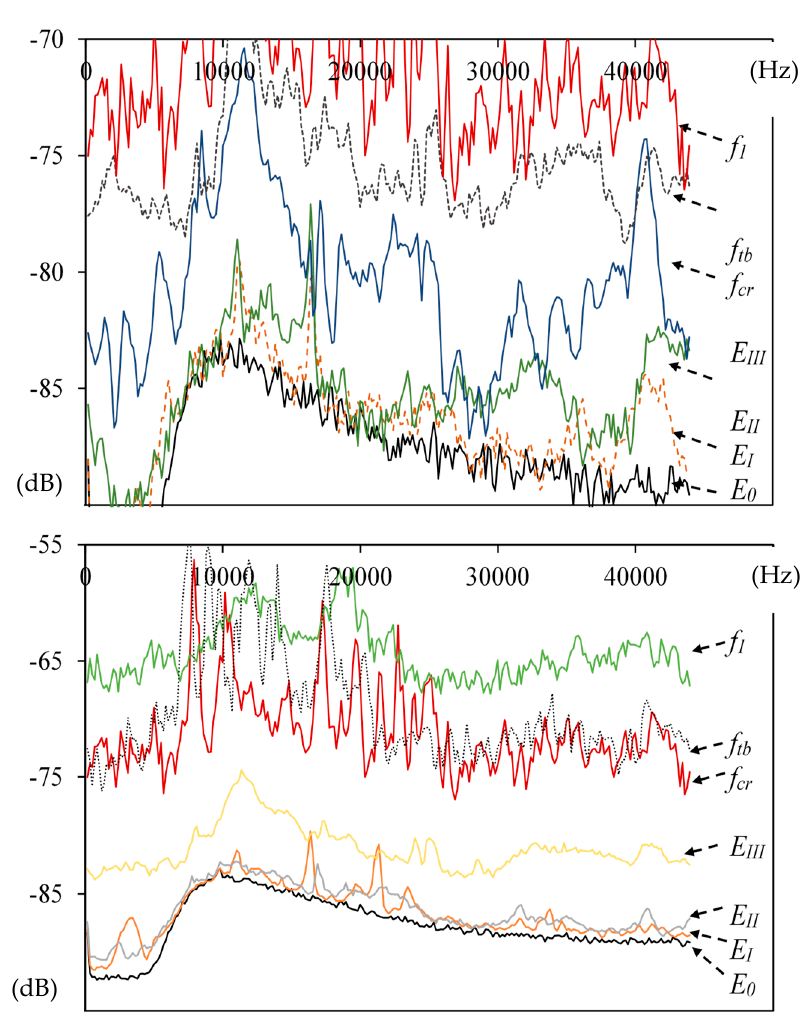
Figure 6. Sound spectra for characteristic events: sound background E 0 and ranges of events: E I , E II , E III .